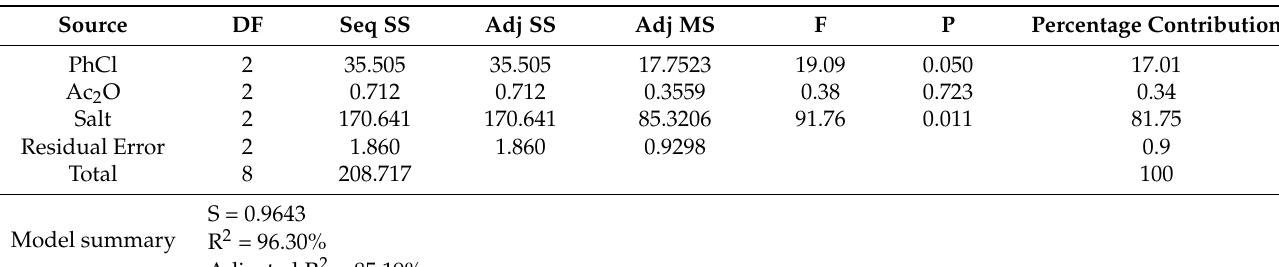
Table 3. Analysis of variance for SN ratios.